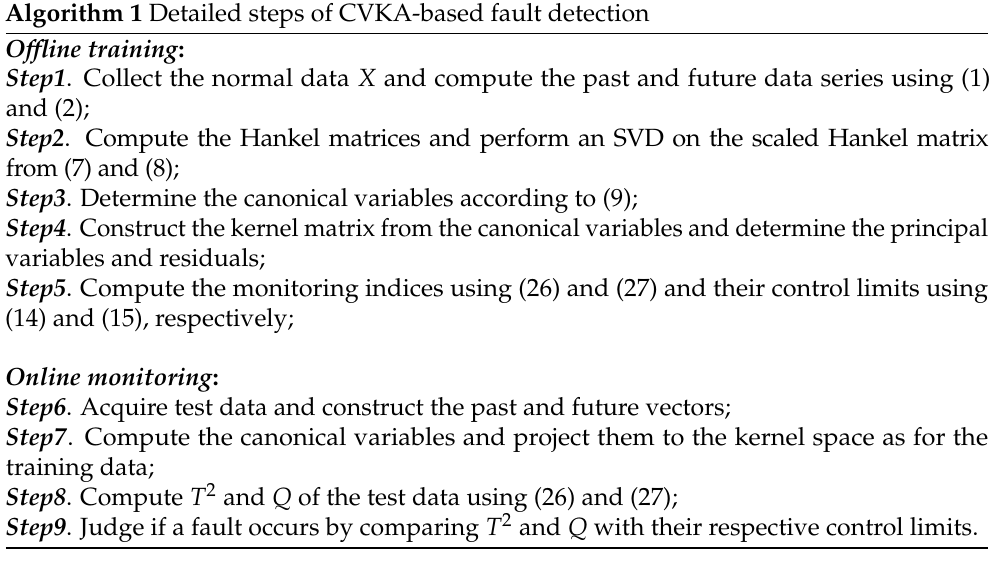
Algorithm 1 Detailed steps of CVKA-based fault